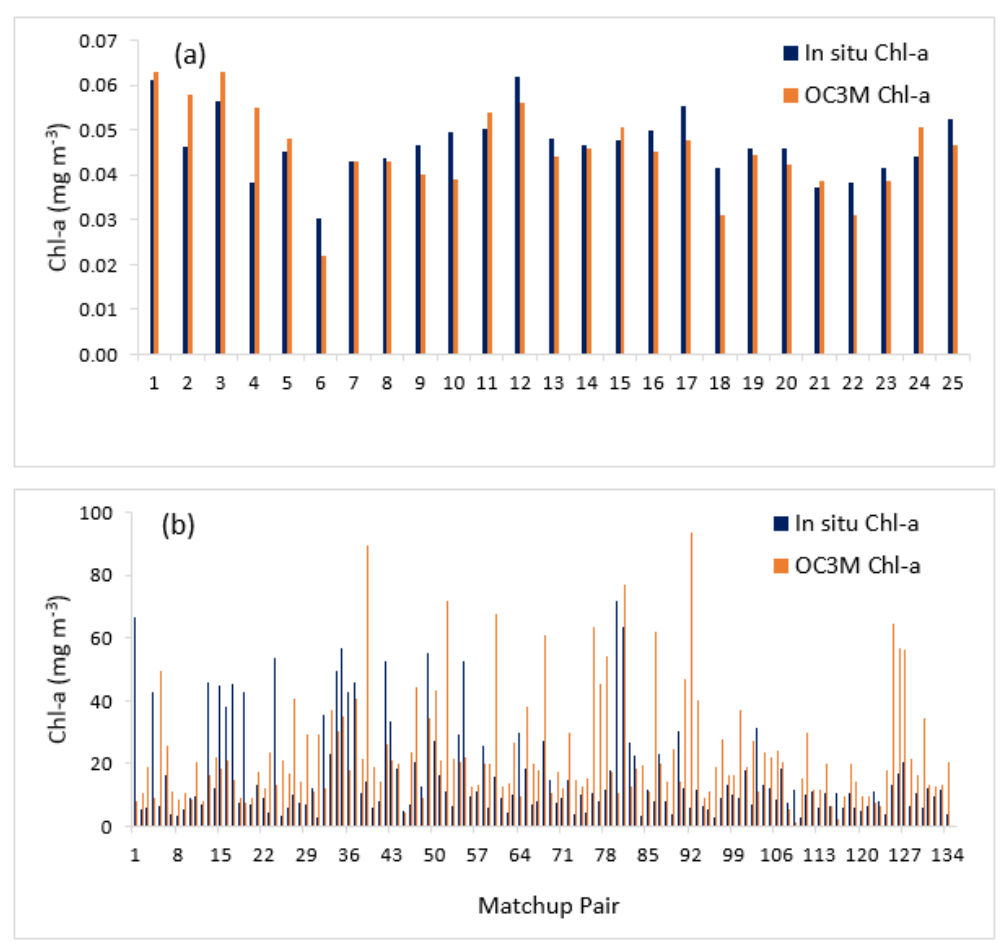
Figure 4. Clustered columns compare the OC3M algorithm derived and in situ Chl-a concentrations in ( a ) Sargasso Sea (case 1) and ( b ) Chesapeake Bay (case 2). Table 3. Statistics assessing accuracy of Ocean Color 3M (OC3M) derived Chl-a in Sargasso Sea (case 1) and Chesapeake Bay (case 2) water.